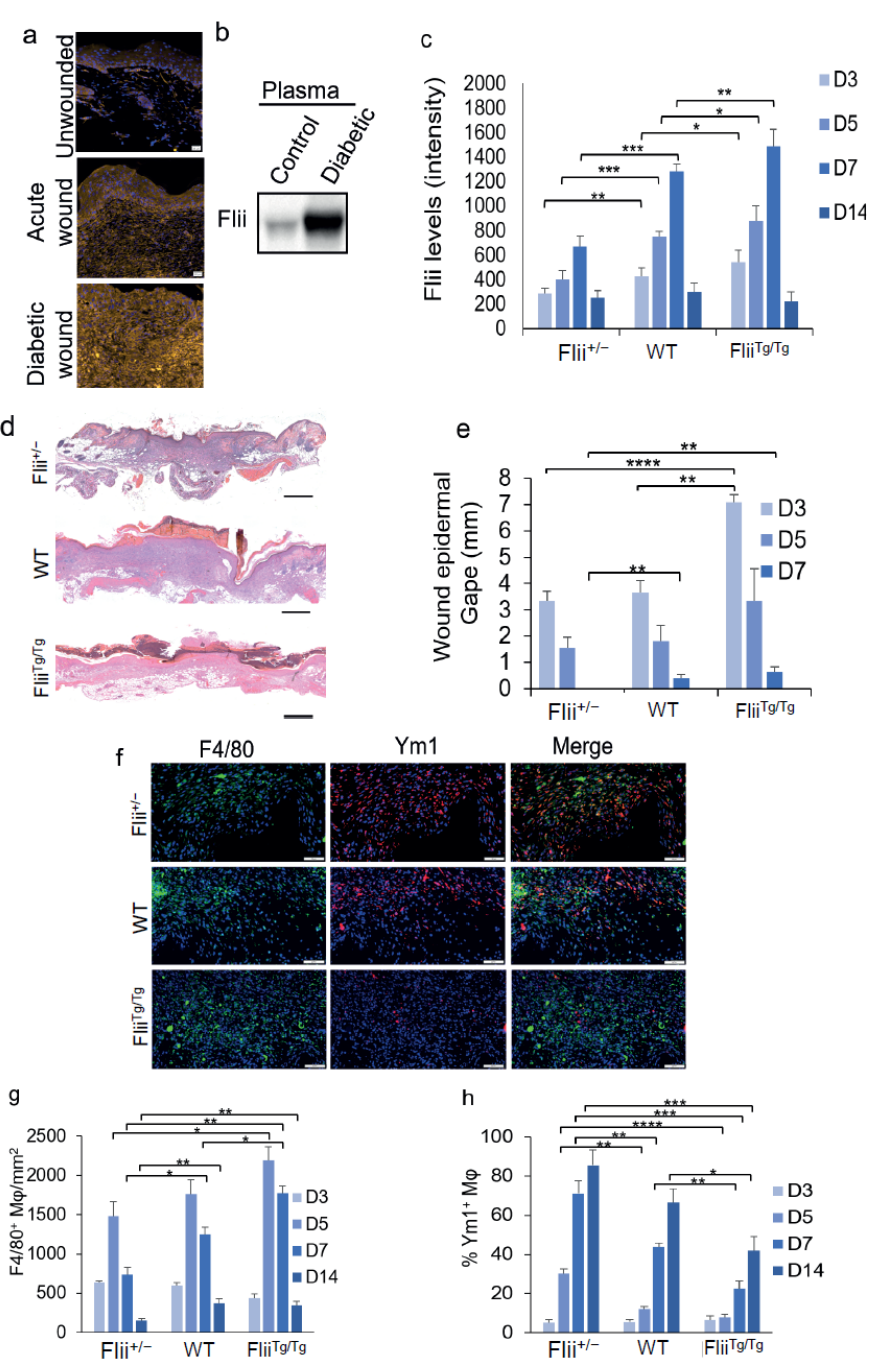
Figure 6. Flii expression and wound closure in a diabetic mouse model: ( a ) Mouse unwounded skin, and acute healthy and diabetic wounds immunostained for Flii; ( b ) Representative Western blot of Flii expression in plasma from diabetic mice; ( c ) Bar graph showing Flii expression levels in murine